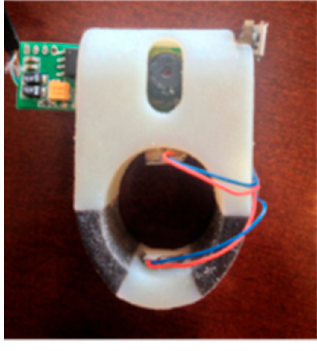
Figure 26. The prototype of FingerReader [47].